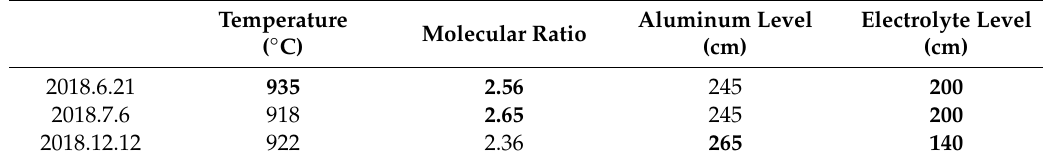
Table 5. Analysis of some unstable